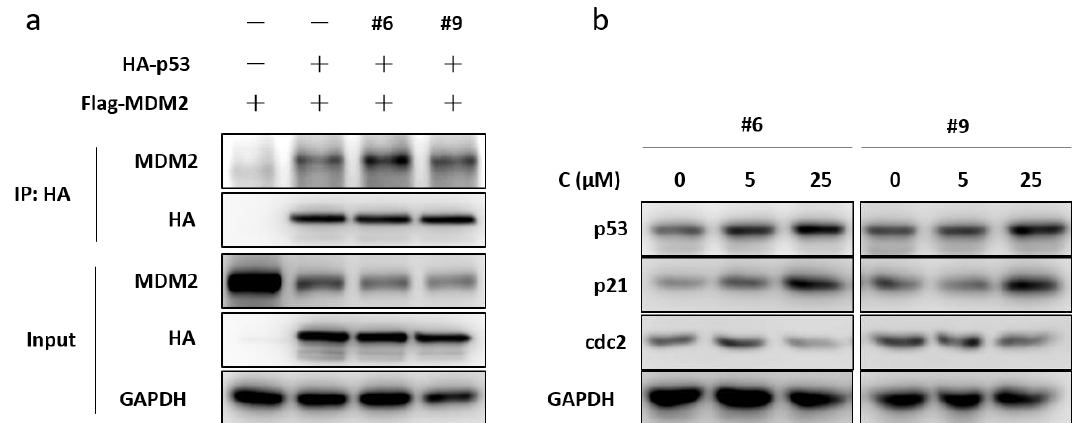
Figure 2. The activation of p53 pathway and p53 up regulation in HCT116 cells by compounds 6 , 9 (western blotting).